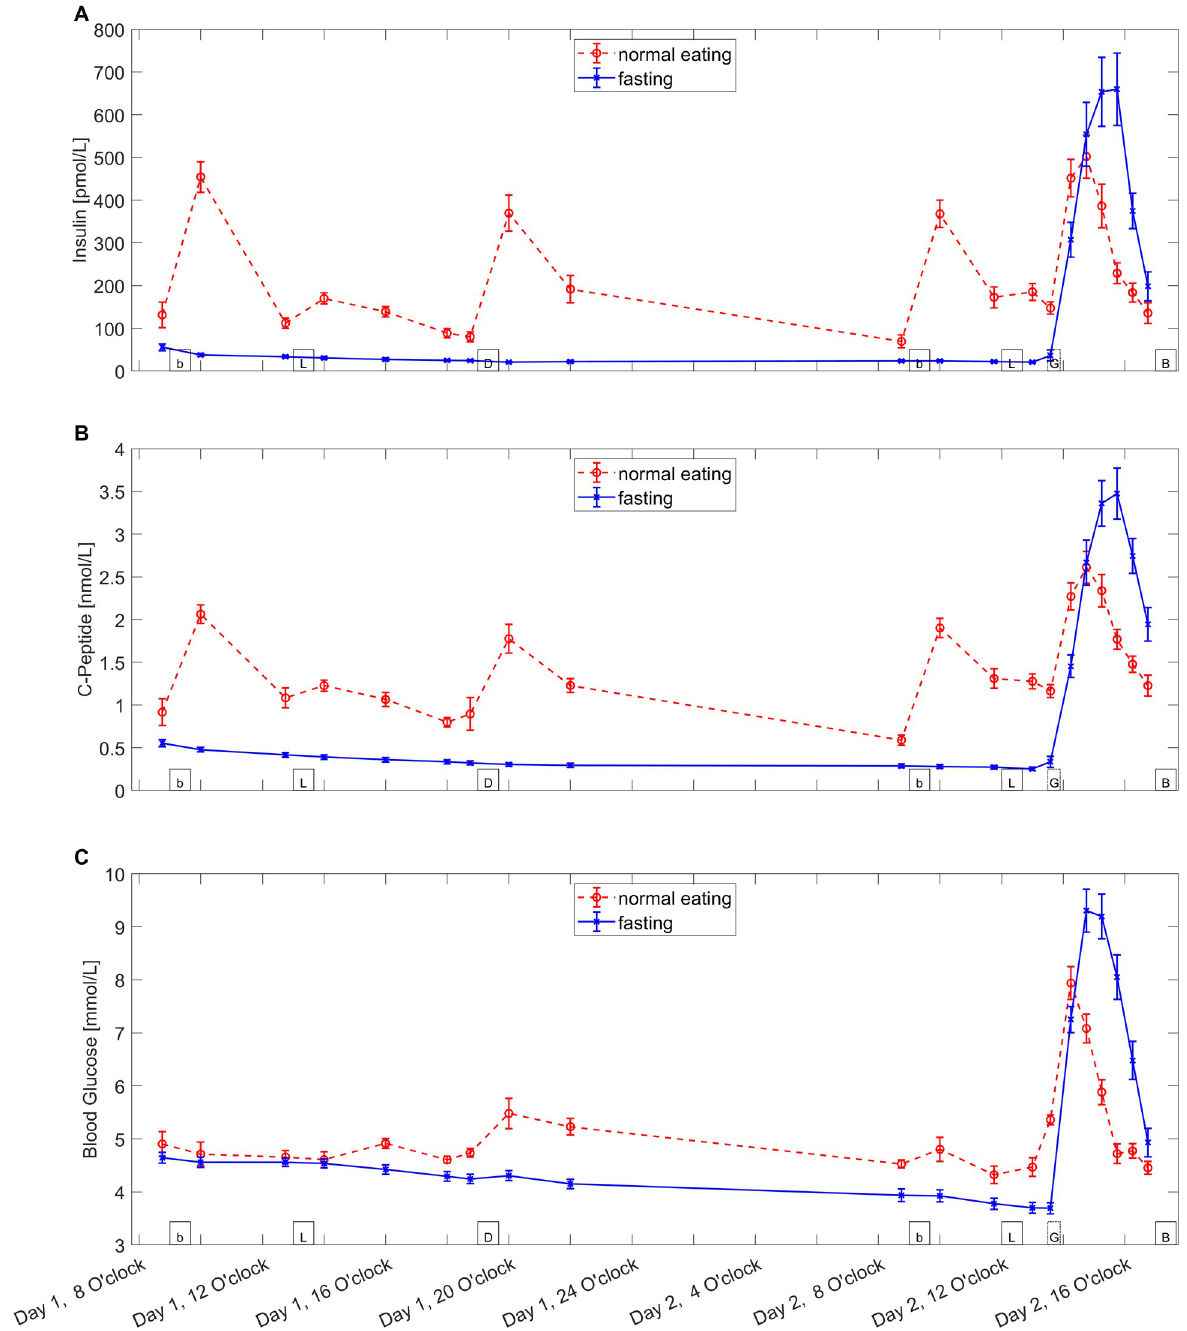
Fig 3. Levels of insulin (A), C-peptide (B), blood glucose (C). The Figure shows the mean ± standard error of the mean for both fasting (blue line, crosses) and normal eating (red spotted line, circles) condition of the serum parameters during the experiment. Boxes on the bottom of the graph indicate the timepoints of meals (b = breakfast, L = lunch, D = Dinner, G = oral glucose administration, B =